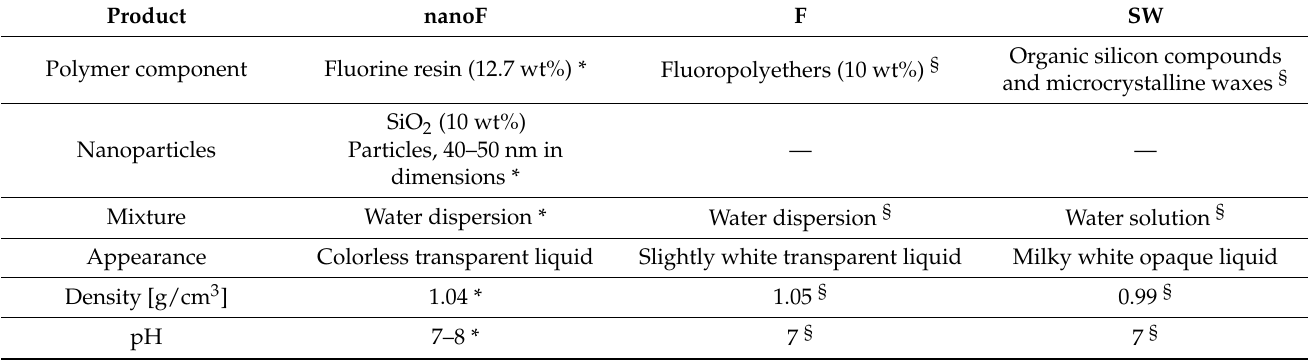
Table 1. Details of the used protective products (* data supplied by Kimia S.p.A.; § from the technical